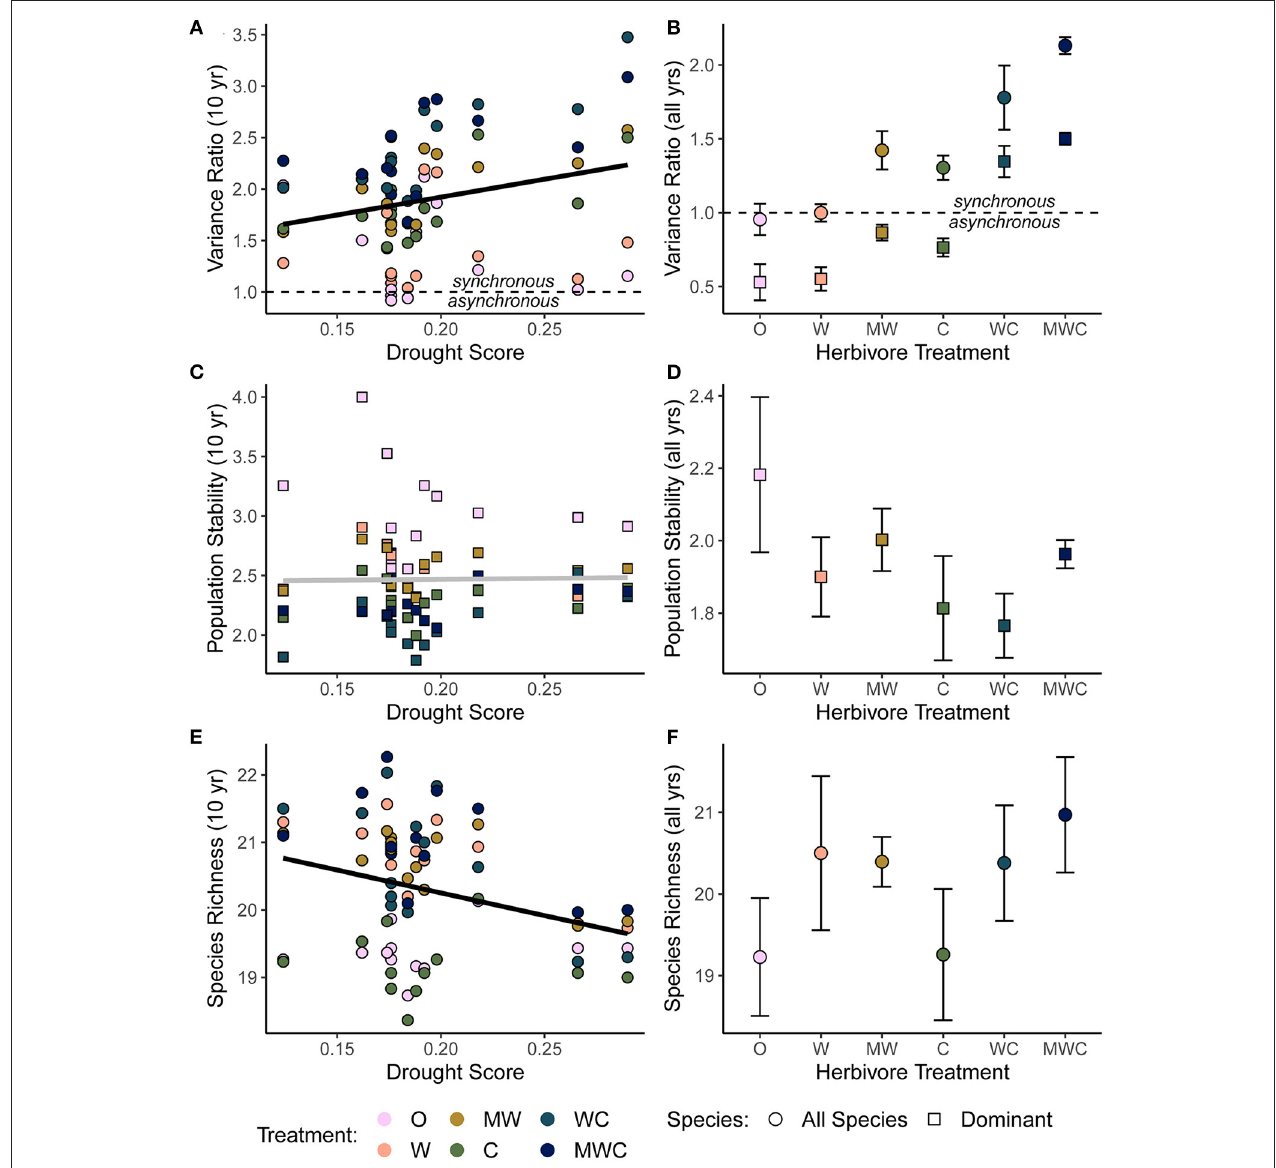
FIGURE 4 | The relationship between the variance ratio (A) , dominant species population stability (C) , species richness (E) and drought, all calculated over a 10-year moving window in order to compare to the corresponding drought score of each time window. The effects of herbivore treatment on the variance ratio (B) , dominant species population stability (D) , and species richness (F) calculated as an average over the full timeseries. A variance ratio less than one indicates asynchronous dynamics, and greater than one indicates synchronous dynamics. Shape indicates whether the biotic mechanism is calculated using all species in the community (circles) or only the five dominant species (squares). Bars are one standard error. Black regression lines in (A,E) are plotted when the predictor was included in the top model and the gray regression line in (C) indicates that this predictor did not have an effect. Figures are based on raw data, but statistical models include random effects to account for spatial and temporal autocorrelation. See Tables 2 , 3 for model details. Herbivore treatments (ordered by total herbivore biomass) are: O, No herbivores; W, Wild mesoherbivores; MW, Wild megaherbivores and wild mesoherbivores; C, Cattle; WC, Wild mesoherbivores and cattle; MWC, Wild megaherbivores, wild mesoherbivores, and